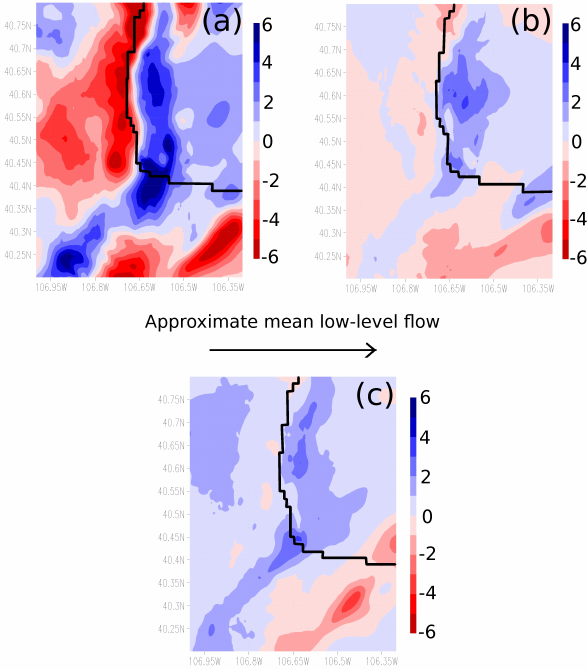
Fig. 7. The simulated difference in total storm-period precipitation (mm) between (a) A1-A10, (b) B1-B10, (c) C1-C10 is shown. Pos- itive values (indicating, for example, areas that received more total precipitation in A1 than in A10) are shaded in blue. The continental divide is marked by the solid black line and the approximate direc- tion of the mean low-level flow is